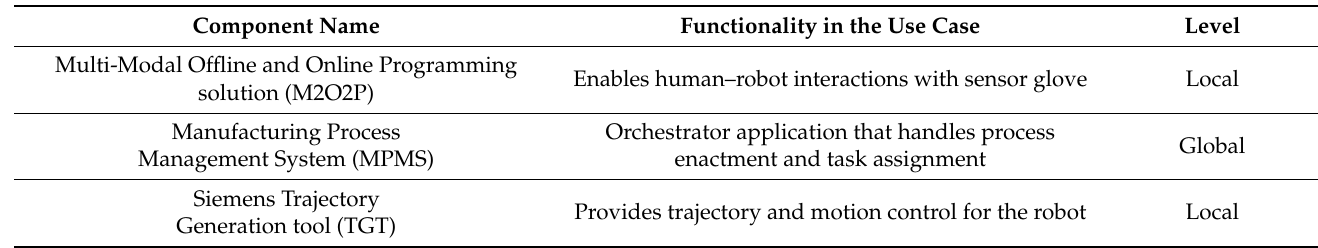
Table 2. Software components used in the use case.